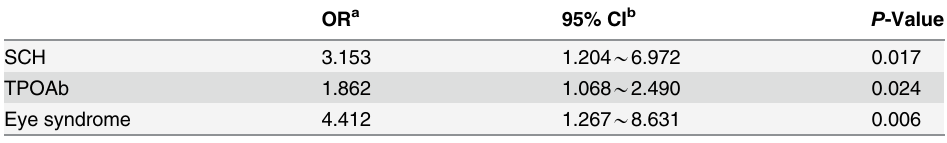
Table 5. Multivariate logistic regression analysis of risk factors of depression after 131 I treatment of Graves ’